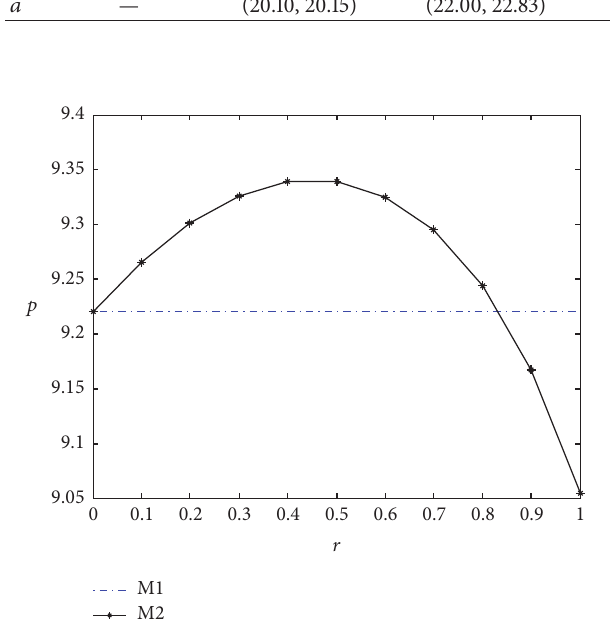
Figure 9: Optimal price comparison in models M1 and M2 ( 𝐴 = 20 , 𝑎 = 33